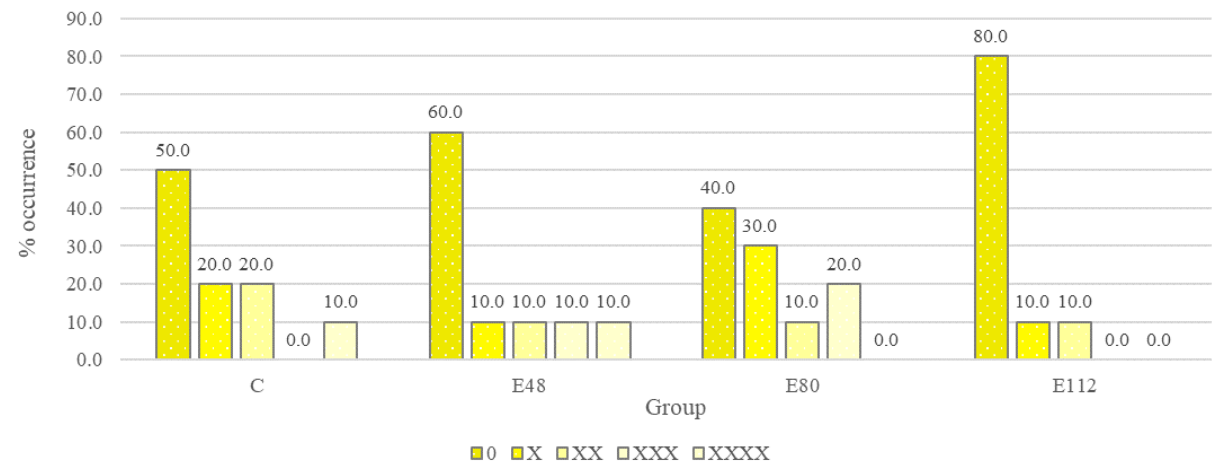
Figure 6. Distribution of samples by response rate and level of occurrence at the beginning of the experiment ( n = 10).